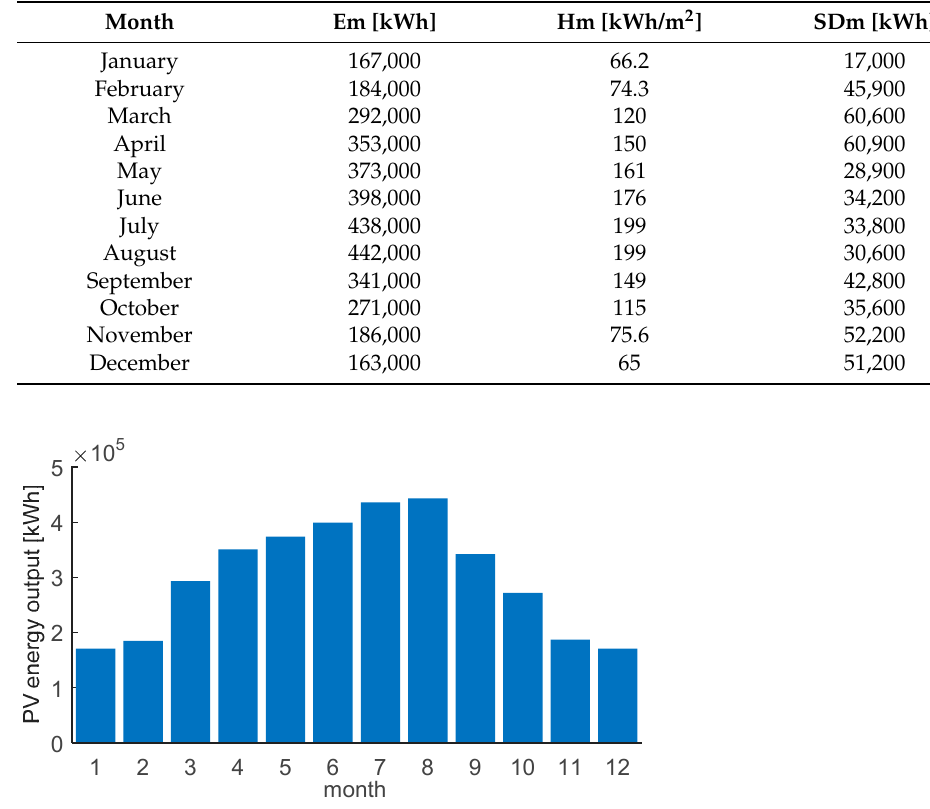
Table 8. Data obtained by creating reports in PVGIS software.